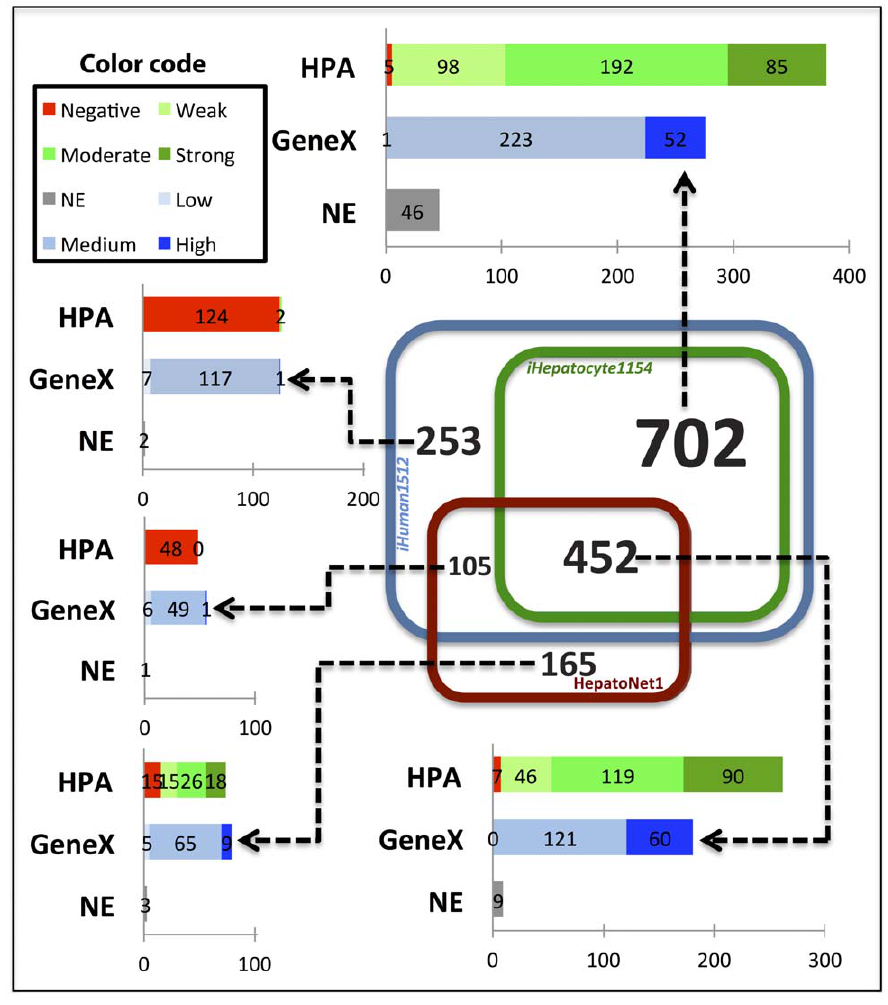
Figure 3. Gene content comparison between our hepatocyte model and HepatoNet1. The Venn diagram shows the overlap in terms of included genes between three models. The blue, green and red squares represent iHuman1512 , our hepatocyte model iHepatocyte1154 and HepatoNet1, respectively. The distribution of evidence scores of each section of the Venn diagram is plotted. The HPA evidence scores are illustrated as red, light, medium and dark green represent negative, weak moderate and strong expression, respectively. The transcriptome evidence scores (GeneX) are illustrated as red, light, medium and dark blue representing low, medium and high expression, respectively. No evidence (NE) is illustrated as grey color.